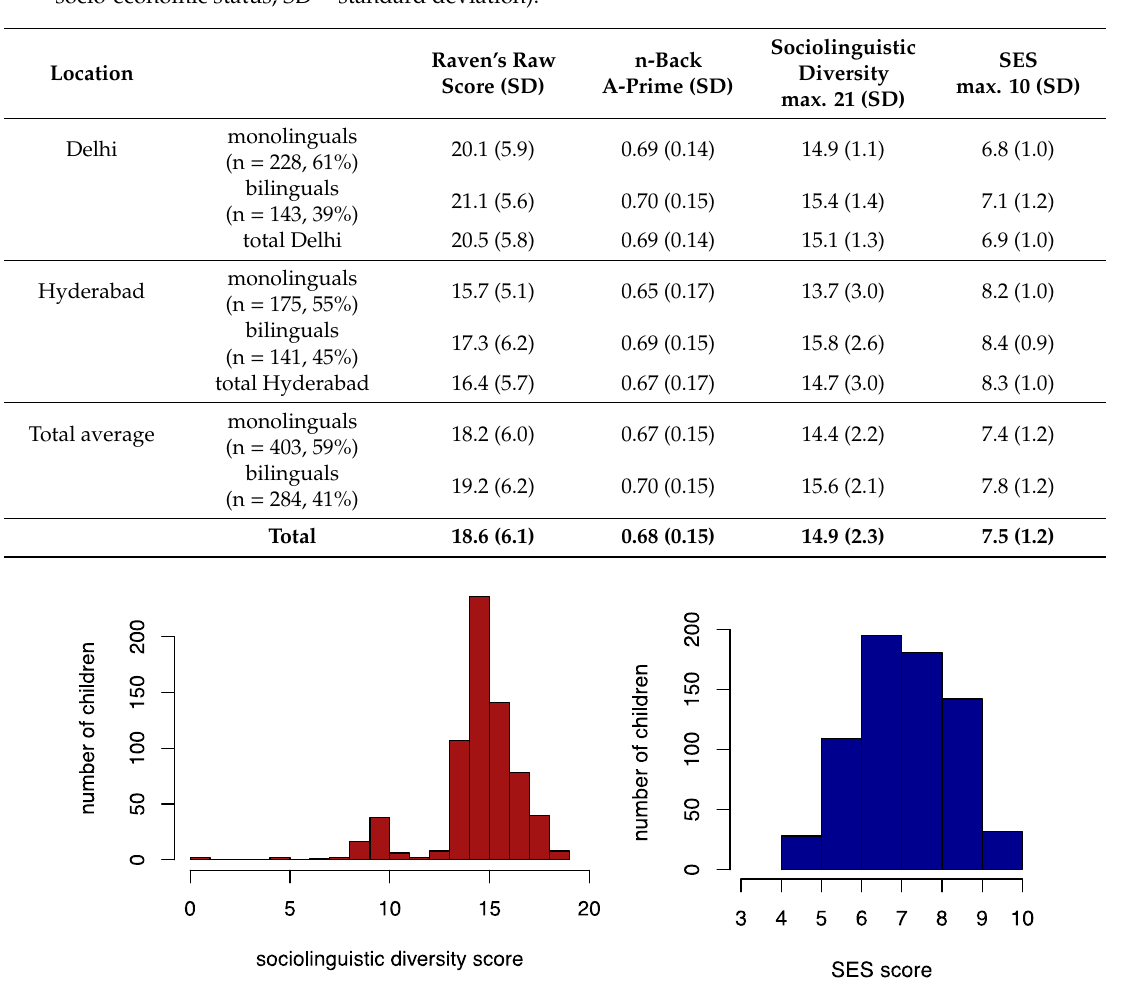
Figure 1. Distribution of the scores on sociolinguistic diversity ( left graph) and socio-economic status (SES, right graph), based on the questionnaires.